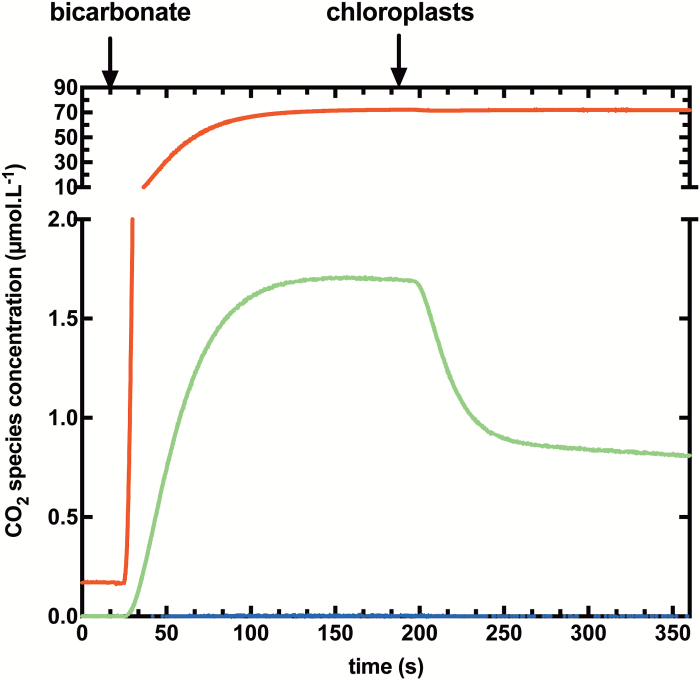
Typical time course for a low 18O-enriched permeability assay. Changes in the concentrations of 13C18O18O (m/z=49, blue), 13C18O16O (m/z=47, green), and 13C16O16O (m/z=45, red) species are shown. After injection of low 18O-enriched Ci (equilibrated against 1.2% [18O]water), chemical equilibrium is reached before chloroplast injection at 200 s.